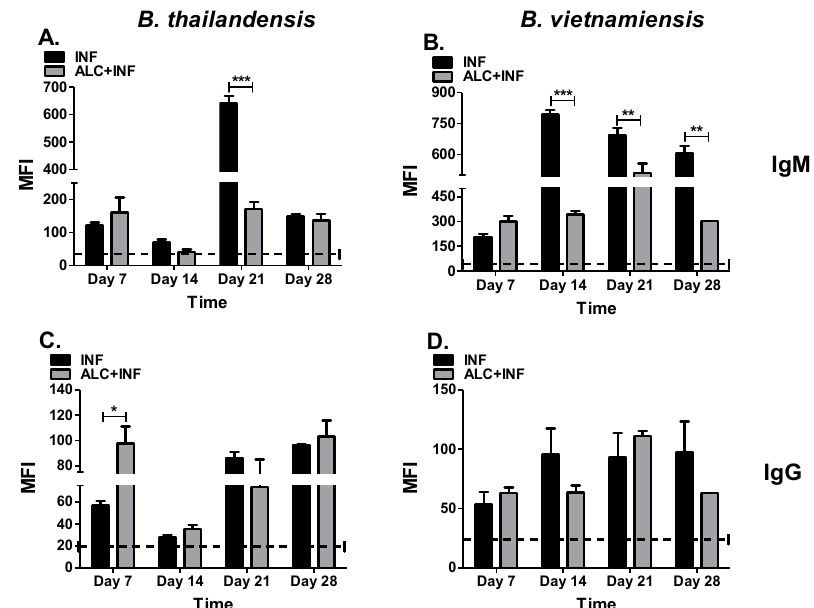
Figure 7. Specific IgM and IgG targeting lipopolysaccharide (LPS)-A of B. thailandensis and B. vietnamiensis . The mice were treated as described in Figure 3. Whole blood was collected weekly until 28 days PI. LPS-A (5 µ g) was coupled to MagPix microspheres and reacted with a 1:1000 serum dilution from infected mice (INF) or mice infected and exposed to alcohol (ALC + INF). Specific LPS-A IgM B. thailandensis ( A ) or B. vietnamiensis ( B ), or LPS-A IgG B. thailandensis ( C ) or B. vietnamiensis ( D ) were measured from serum samples. Bars represent mean fluorescence intensity (MFI) per treatment with SEM. Dashed lines represent base values of control groups (CON or ALC). Horizontal line represents statistical comparison between INF and ALC + INF among weekly blood collections determined by Student’s t -test, n = 3. * p < 0.05, ** p ≤ 0.01, and *** p ≤ 0.001.